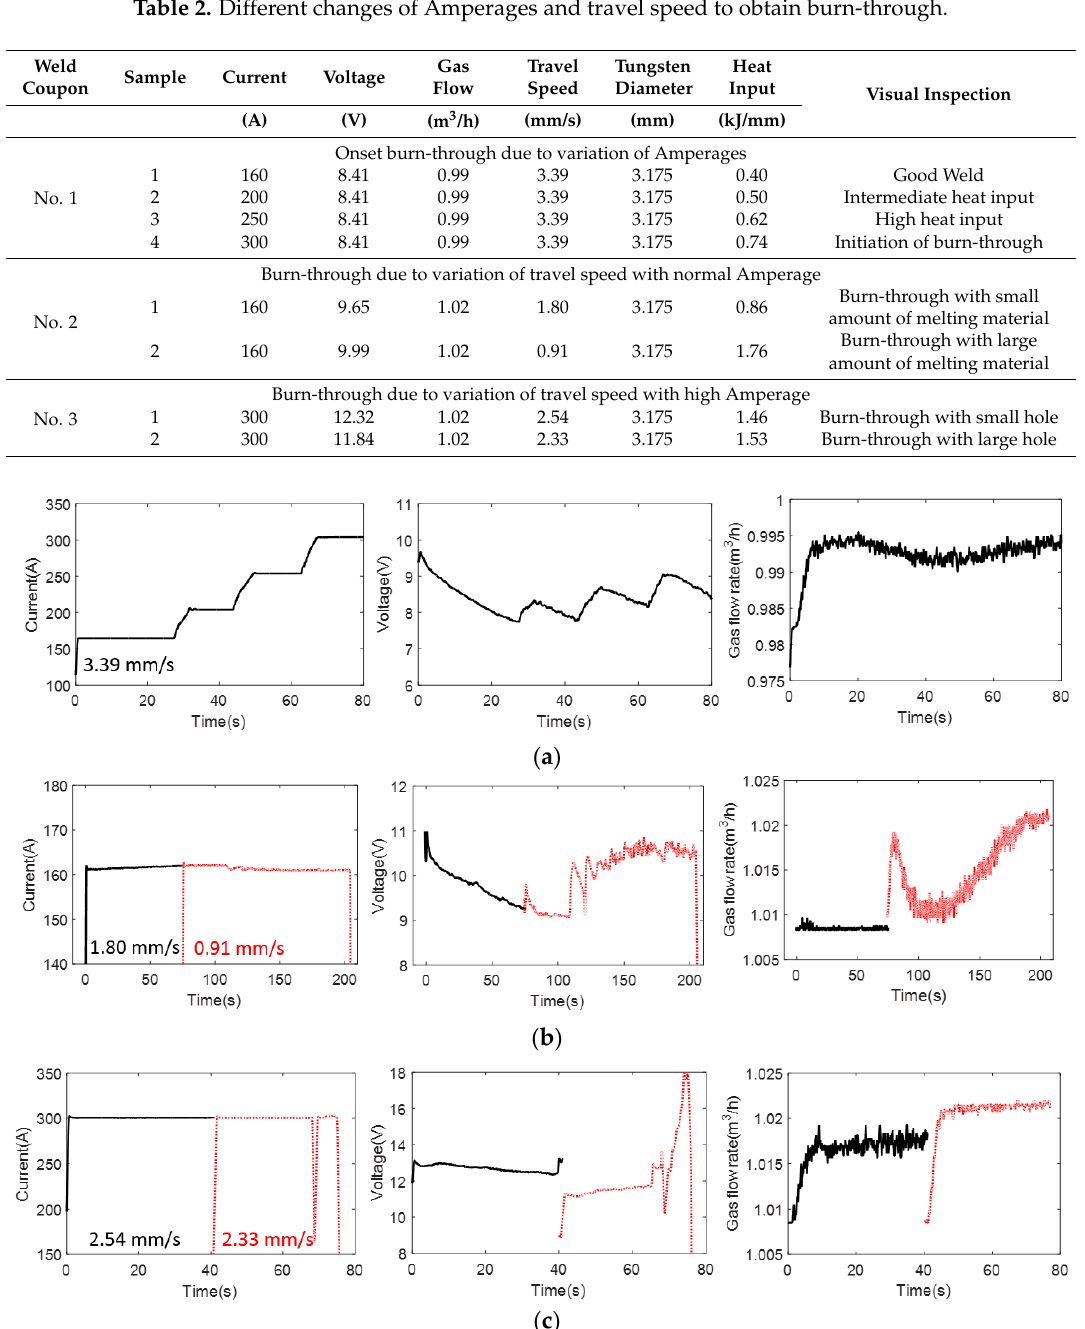
Figure 2. The welding current, voltage, and gas flow for producing a burn-through defect corresponding to ( a ) sample No. 1; ( b ) sample No. 2; and ( c ) sample No.